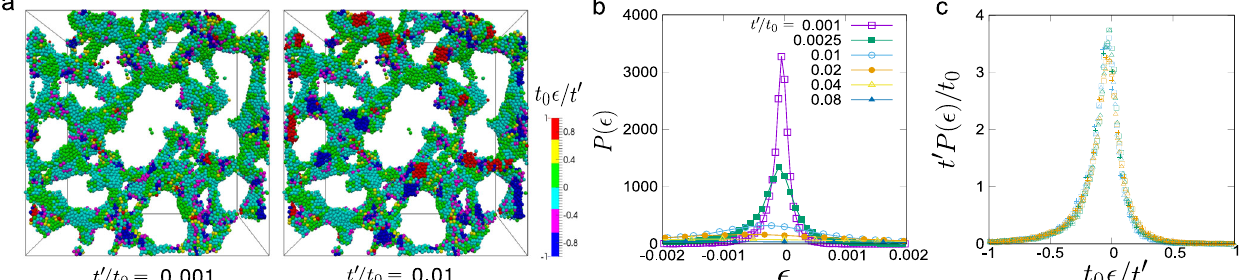
Fig. 5 Volume strain in the colloid-rich domain. a Real-space mapping of the local volume strain around each particle. Colour labelled on the particles represents the value of the scaled local volume strain t 0 ϵ = t 0 . The reference time of the strain is chosen as t 0 = 62.0. Here we show only particles which are located in the top one-quarter of the simulation box to make the details of structures visible. b Time evolution of the distribution of local volume strain, P ( ϵ ). Here t 0 represents the duration of time from the reference time, t = 62.0, to measure the strain. c P ( ϵ ) after scaling ϵ by t 0 = t 0 0 . The data are sampled from the data whose reference time is t 0 = 31.0 (blue), 46.5 (green), 62.0 (brown). Then, cross, triangle and square symbols represent the data at t 0 = t ¼ 0 : 001 ; 0 : 01 ; 0 : 02, 0